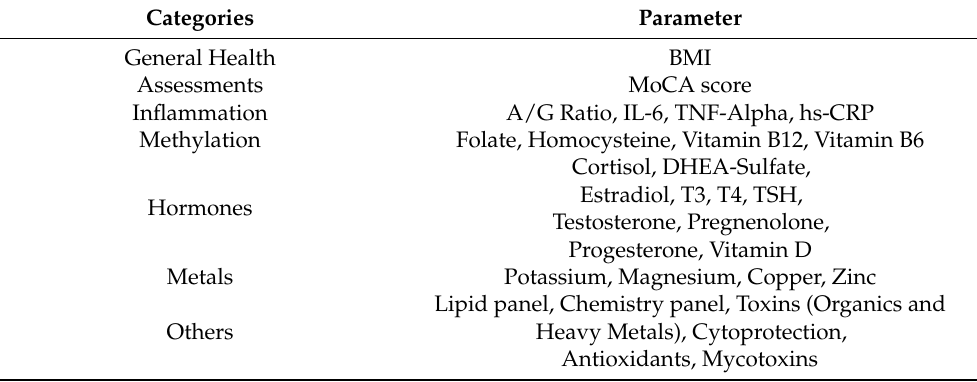
Table 1. A subset of ReCODE evaluation panel